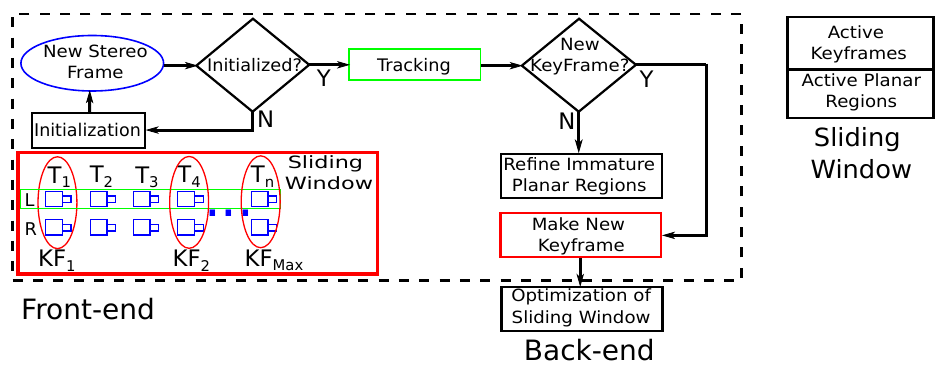
Figure 3. Framework of the proposed